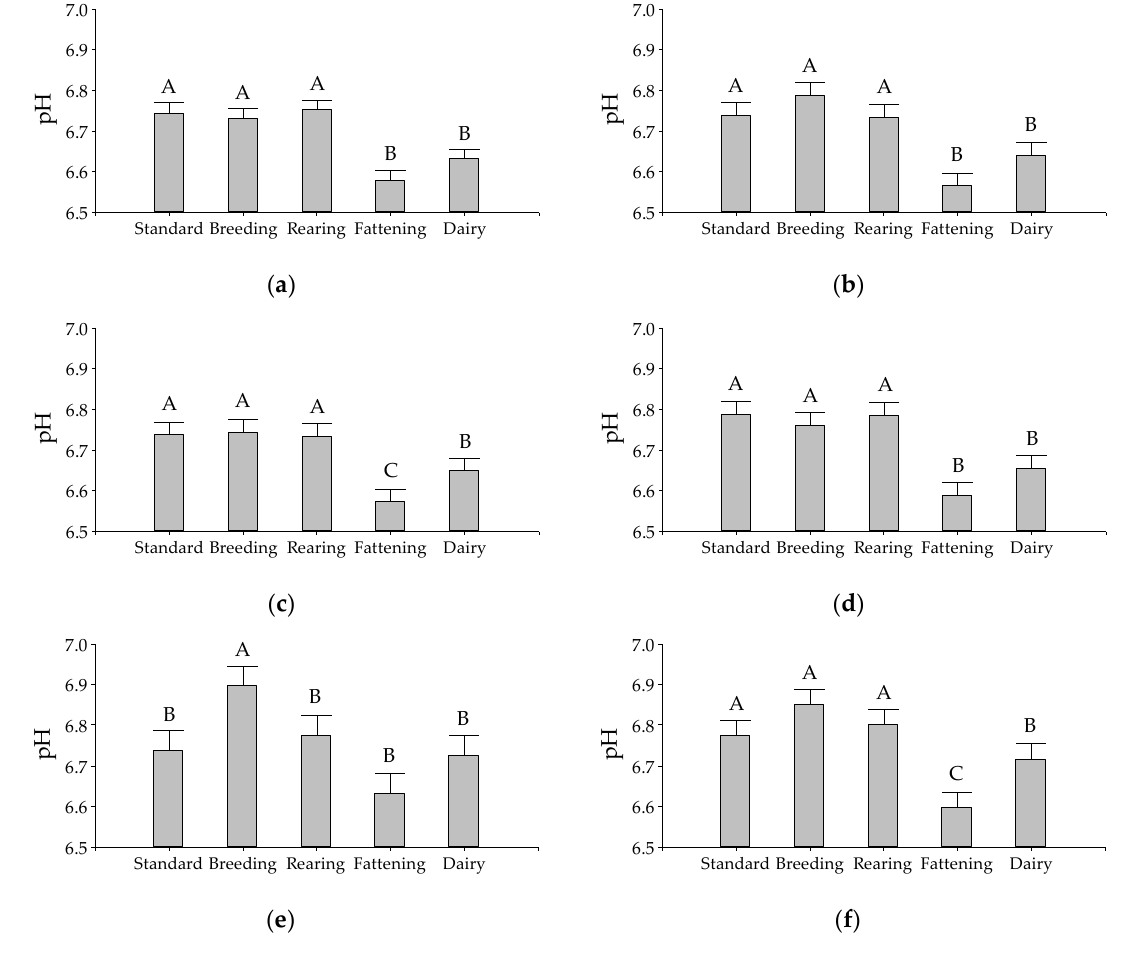
Figure 1. E ff ect of substrate on medium pH after 48 h in vitro incubation for di ff erent doses of essential oil of Lippia turbinata : ( a ) 0 µ L / L (control); ( b ) 0.3 µ L / L; ( c ) 3 µ L / L; ( d ) 30 µ L / L; ( e ) 300 µ L / L; Figure 1. Effect of substrate on medium pH after 48 h in vitro incubation for different doses of essential or ( f ) to the addition of 1.87 mg / L of monensin. The bars represent the standard error of the mean. oil of Lippia turbinata : ( a ) 0 µL/L (control); ( b ) 0.3 µL/L; ( c ) 3 µL/L; ( d ) 30 µL/L; ( e ) 300 µL/L; or ( f ) to A–C Di ff erent letters indicate statistically significant di ff erences between substrates (Di Rienzo, Guzman the addition of 1.87 mg/L of monensin. The bars represent the standard error of the mean. A–C Different and Casanoves (DGC), p -value < letters indicate statistically significant differences between substrates (Di Rienzo, Guzman and Casanoves ( DGC), p -value < 0.05).